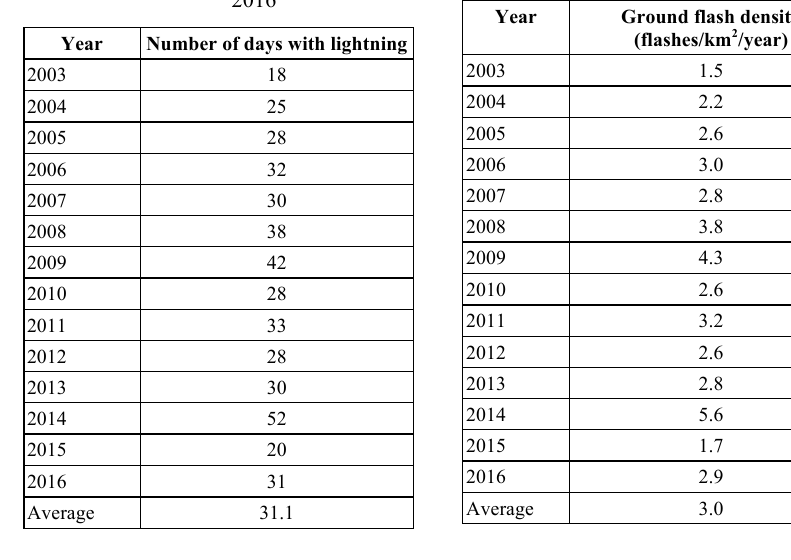
Table 1. Number of days with lightning and Table 2. Ground flash density for Kosovo in average for Kosovo for years 2003-